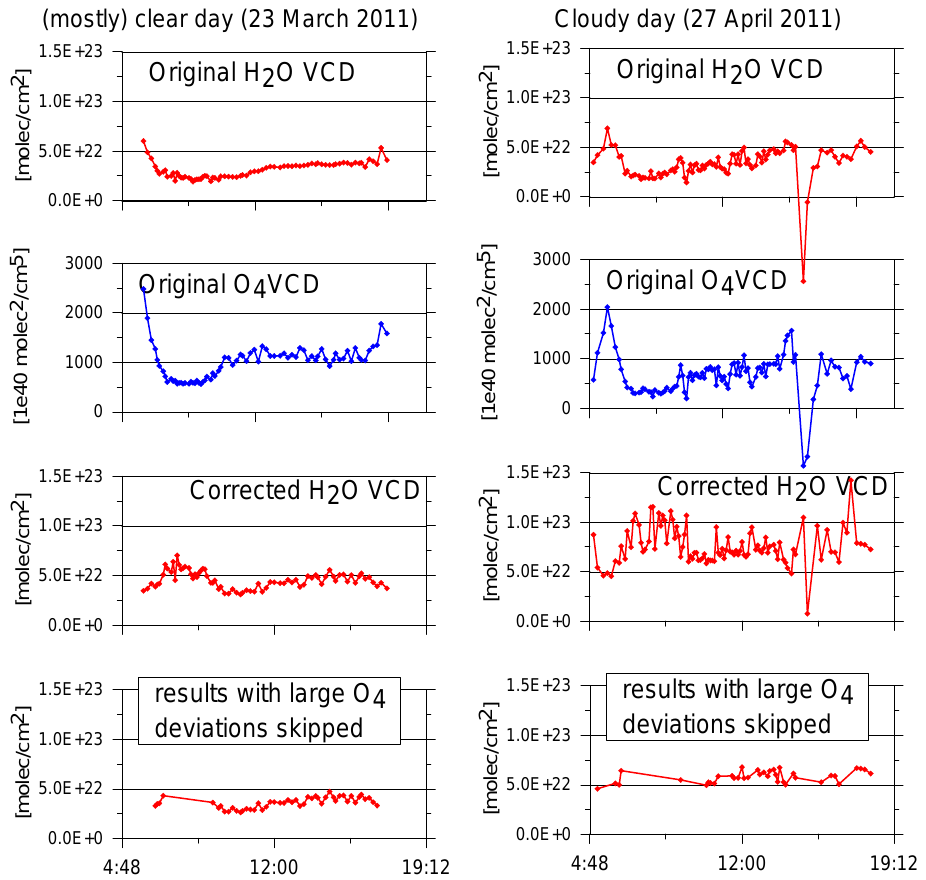
Fig. 6 Illustration of the different processing steps to correct for atmospheric radiative effects for a clear day (left) and cloudy day (right): The two upper rows show the retrieved VCDs of H 2 O and O 4 , for which the influence of aerosols and clouds can lead to large deviations from the true atmospheric VCDs. The third row shows the H 2 O VCDs calculated according to Eq. (6). For these H 2 O VCDs part of the aerosol and cloud effects are corrected. However, especially for the cloudy day, strong and unrealistic variations remain. After applying a filter based on the retrieved O 4 VCDs (see text), the most deviating measurements are removed (bottom row). H 2 O column densities are displayed in red colour, O 4 column densities are displayed in blue colour.